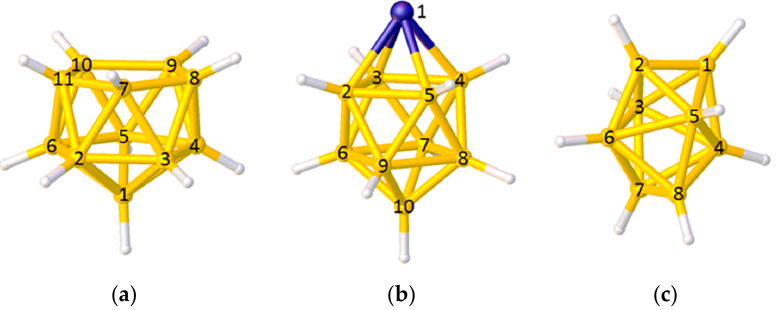
Figure 4. Choosing the correct vertices to define the polyhedral centroid and comparing vertex-centroid distances (VCDs) within an appropriate group: ( a ) A nido 11-vertex polyhedron—the centroid is defined by only vertices 2–11 but all VCDs can be compared as a single group; ( b ) A closo 10-vertex polyhedron with a metal atom at vertex 1—the centroid should be defined by vertices 2–9 only, and only VCDs from these vertices should be compared; ( c ) A closo 8-vertex polyhedron—all vertices are used to calculate the centroid but the VCDs from vertices 1, 2, 7, and 8 and from vertices 3–6 should be considered separately.